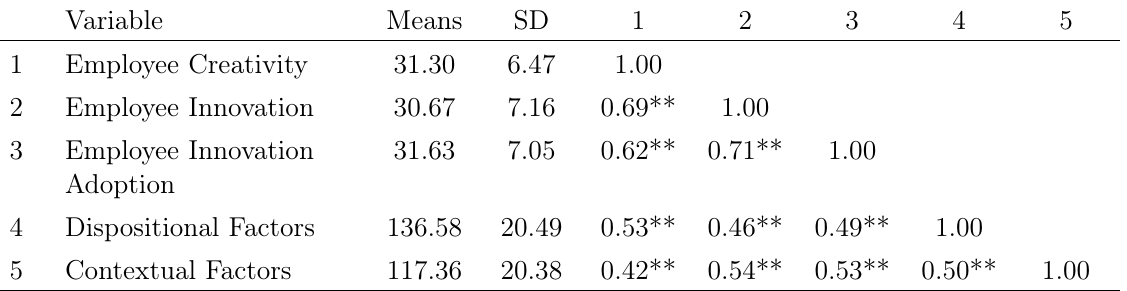
Table 1. Descriptive statistics, correlations among all